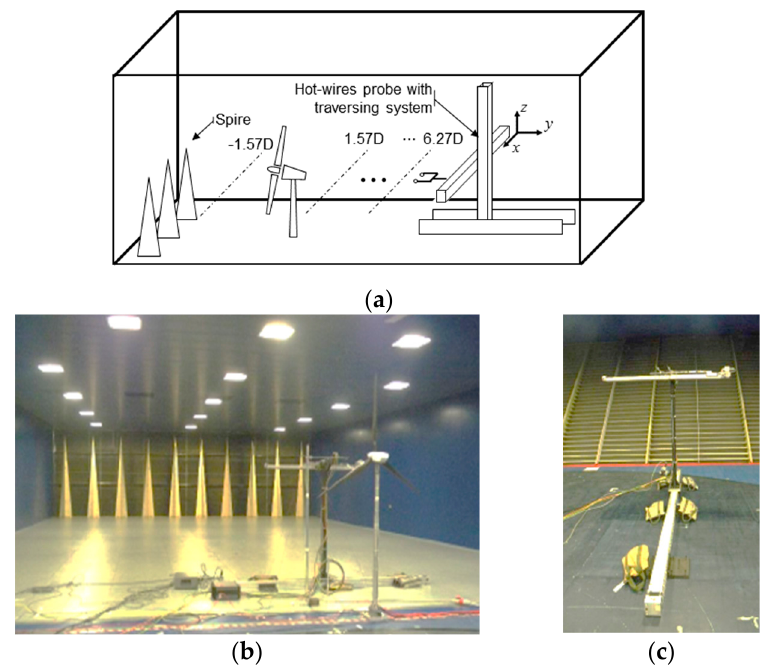
Figure 4. Configuration of the wake measurement setup: ( a ) wind tunnel experimental layout, ( b ) scaled wind turbine and spire, and ( c ) hot wire with traversing system.